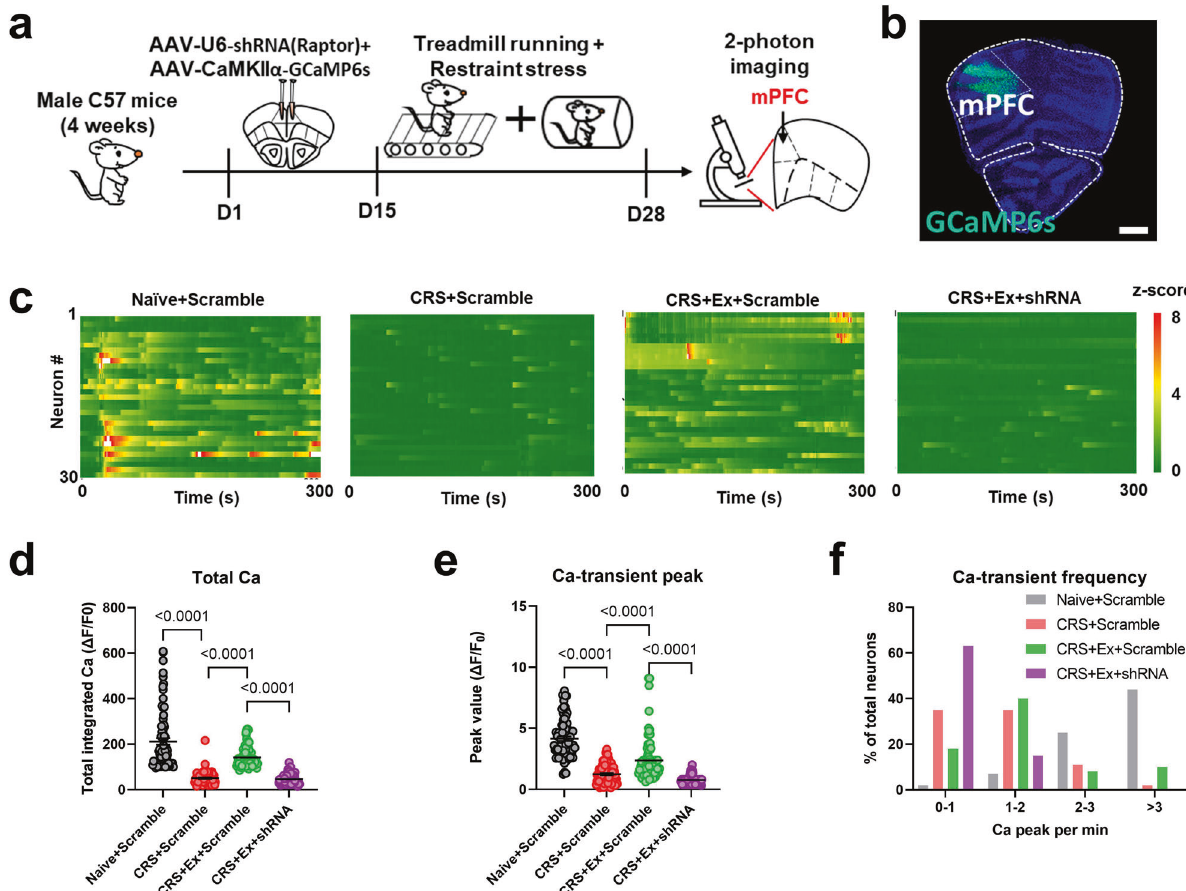
Fig. 4 Brain mTOR pathway regulates cortical neuronal activity. a Experimental fl owchart of in vivo 2-photon imaging assay. b Expression of GCaMP6s in mPFC region. Scale bar, 500 μ m. c Heatmaps showing the in vivo calcium activities of mPFC neurons. A total of 30 neurons were displayed, with the calcium transients transformed as z -scores. d Total integrated calcium levels of mPFC were decreased by CRS and re- elevated by exercise training. The inhibition of the mTOR pathway repressed calcium activities in exercised mice. Nonparametric Kruskal – Wallis test statistic = 234.4, P < 0.0001. e Similar trends were observed for the peak values of calcium transients. Nonparametric Kruskal – Wallis test statistic = 198.1, P < 0.0001. f Frequency distribution of calcium transient frequency (spike per min) also showed lower frequency by Raptor gene knockdown. n = 80 neurons from 4 mice in each group in ( d – f ). Dunn ’ s test was used for the comparison between the two groups. All data were presented as mean ±